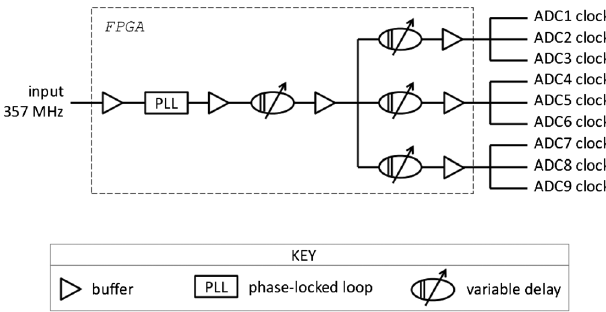
FIG. 15. Schematic of the ADC clock generation in the FONT5 board firmware.